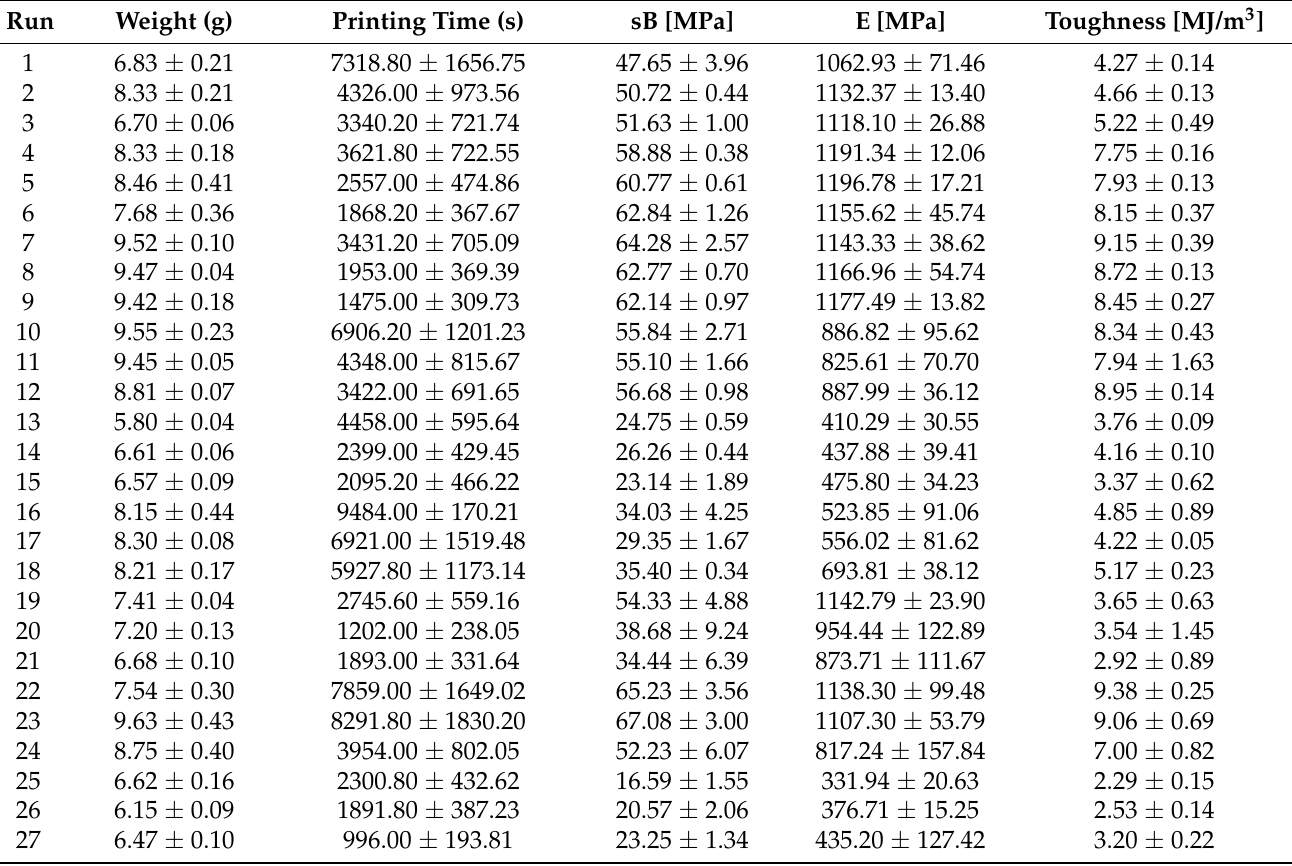
Table 2. Mean average values and standard deviations of measured responses for weight, printing time, compressive strength (sB), compressive modulus of elasticity (E), and compressive